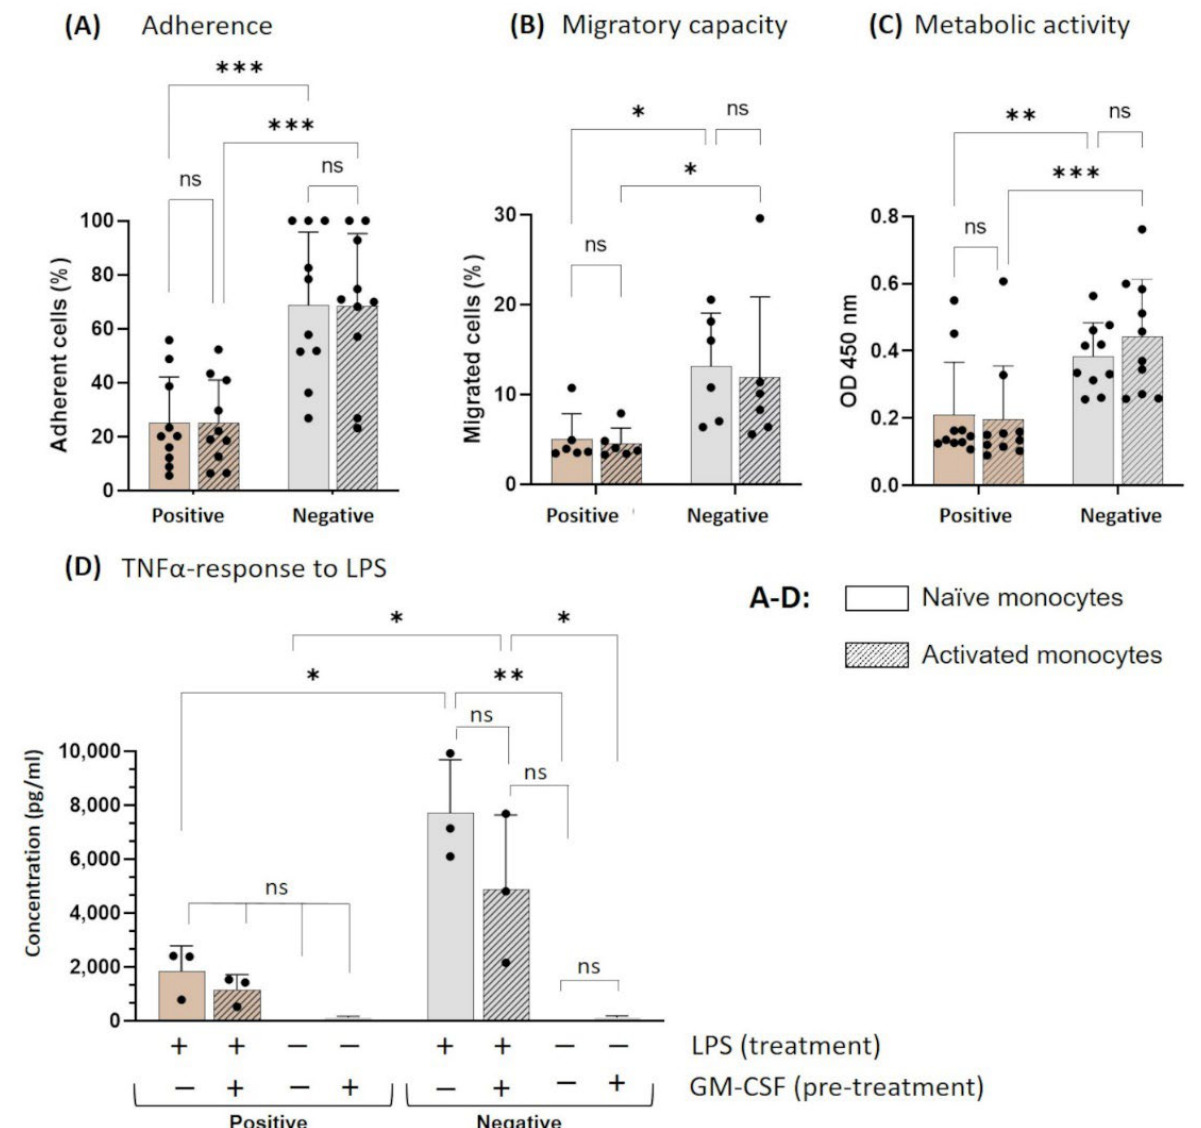
Figure 5. Effect of isolation method on the functionality of non-adherent blood-derived monocytes. After isolation from whole blood, monocytes were cultured for 16 h in suspension culture with GM- CSF (= activated) or left unstimulated (= naïve), followed by the harvest of the non-adherent cells. ( A ) Monocytes were allowed to adhere to fibronectin-coated multiwell plates for 2.5 h to measure the effects on cell adhesion. Adherent cells were enzymatically detached and counted. ( B ) Mono- cytes were seeded in a transwell insert to determine the migratory capacity towards the MCP-1sup- plemented medium. After a 2.5 h incubation period, the cells in the lower compartment of the cham- ber were counted, and the ratio to the number of seeded cells was calculated and indicated as a percentage. ( C ) The metabolic activity of cells was examined in multiwell plates using WST-1 assay. ( D ) The secreted cytokine TNF- α was measured in cell culture supernatants after 24 h of LPS or PBS stimulation by ELISA. Results are presented as single dots representing one sample. Bars indicate means + SD. Pairwise comparisons were calculated using the Tukey–Kramer test. ( A ): n = 10, ( B ): n = 6, ( C ): n = 10, ( D ): n = 3, * p < 0.05, ** p < 0.01, ***, p < 0.001, ns = not significant Abbr.: GM-CSF,